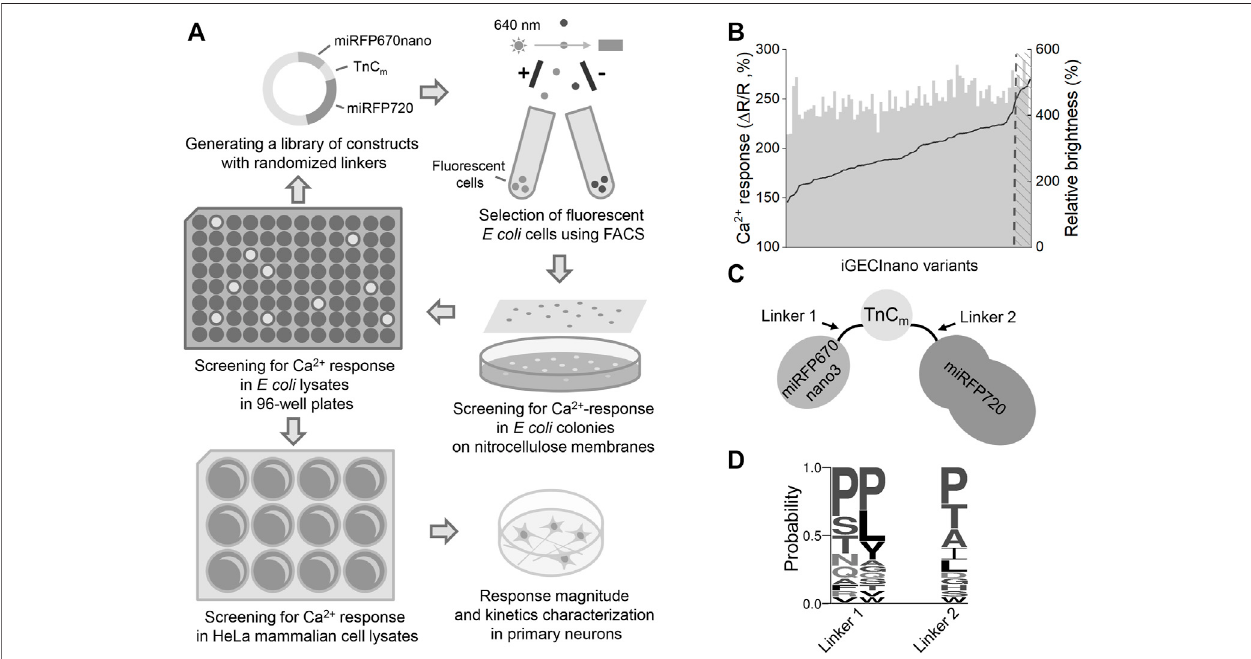
FIGURE1| Theindicatordesignandscreeningstrategy. (A) ThelibraryoftheNIRGECIvariantswithrandomizedlinkerswaspre-sortedforpositive fl uorescenceof miRFP670nano and miRFP720. Collected cells were plated on Petri dishes, mature colonies transferred to nitrocellulose membranes and screened for the calcium response by spraying with ionomycin/EGTA solution, then with the Ca 2+ solution and comparing with the miRFP670nano/FRET ratio. The colonies demonstrating the highest response were further used for screening in bacterial lysates, then in mammalian lysates. The fi nal indicator variant was tested in cultured neurons. (B) Evolution of iGECInano variants in bacteria. The amplitude of the FRET/donor ratio change in response to 1 mM Ca 2+ (black) and relative brightness (gray) of the tested indicator variants. The brightness of the iGECInano variants was normalized on the brightness of iGECI. Variants with a response above the 250% threshold were sequenced and tested in HeLa cells. (C) Schematic of the iGECInano structural design. A minimal TnC-based Ca 2+ -sensing domain TnC m derived from Twitch-2B indicator issandwiched between aFRET pair ofmiRFP670nano (FRET donor) and miRFP720 (FRET acceptor). (D) Thefrequencyofaminoacid residues in randomized linkers of iGECInano variants, having a Ca 2+ response above 250%